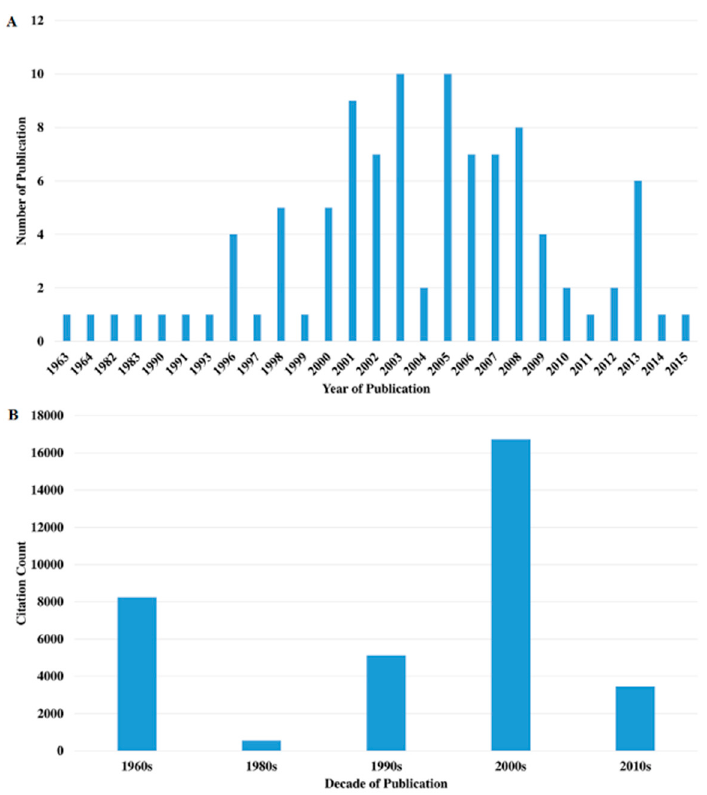
Figure 2. Citation analysis of the top 100 most-cited articles over the ( A ) years and ( B ) decades.